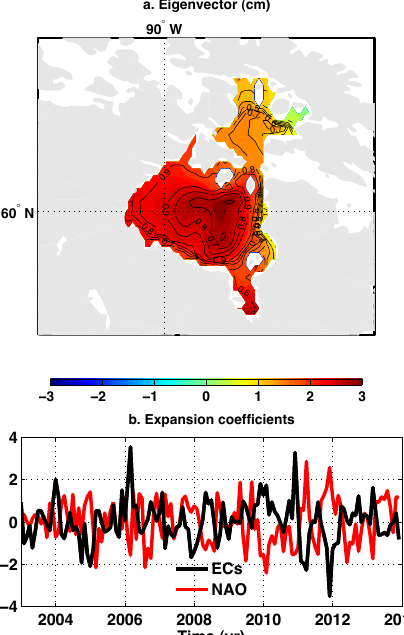
Figure 4. Leading empirical orthogonal function (EOF) of nonsea- sonal sea level determined from the barotropic model in the Cana- dian inland seas. (a) Shading is the value of the leading eigenvector (cm). Contouring is the local fraction of simulated anomalous sea level variance explained by the leading EOF. (b) Nonseasonal time series of the leading expansion coefficients (black) normalized to have unit variance. Also shown is the NAO with a linear trend and a seasonal cycle removed (red). The NAO time series is taken from the National Oceanic and Atmospheric Administration’s Earth Sys- tem Research Laboratory Physical Sciences Division